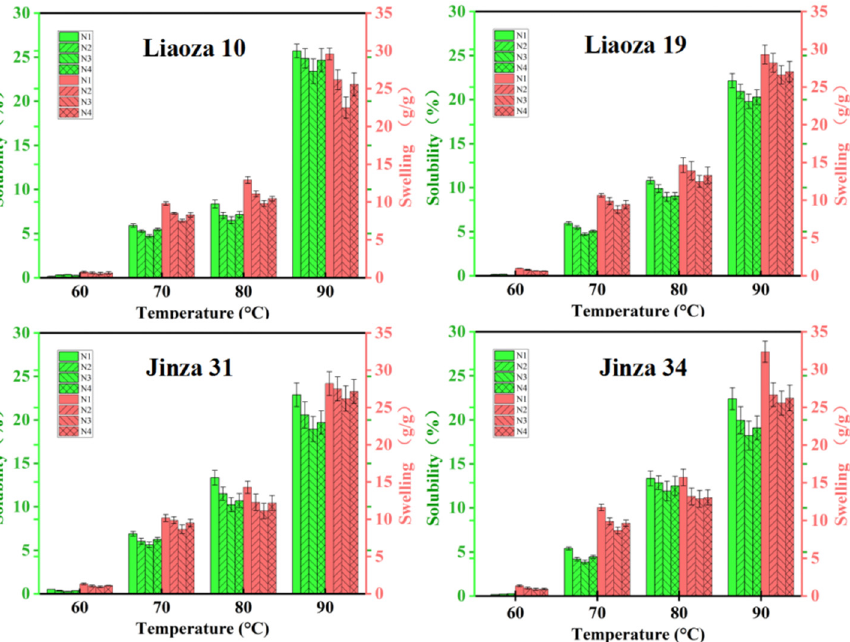
Figure 5. Effects of different nitrogen levels on solubility and swelling degree of sorghum starch.